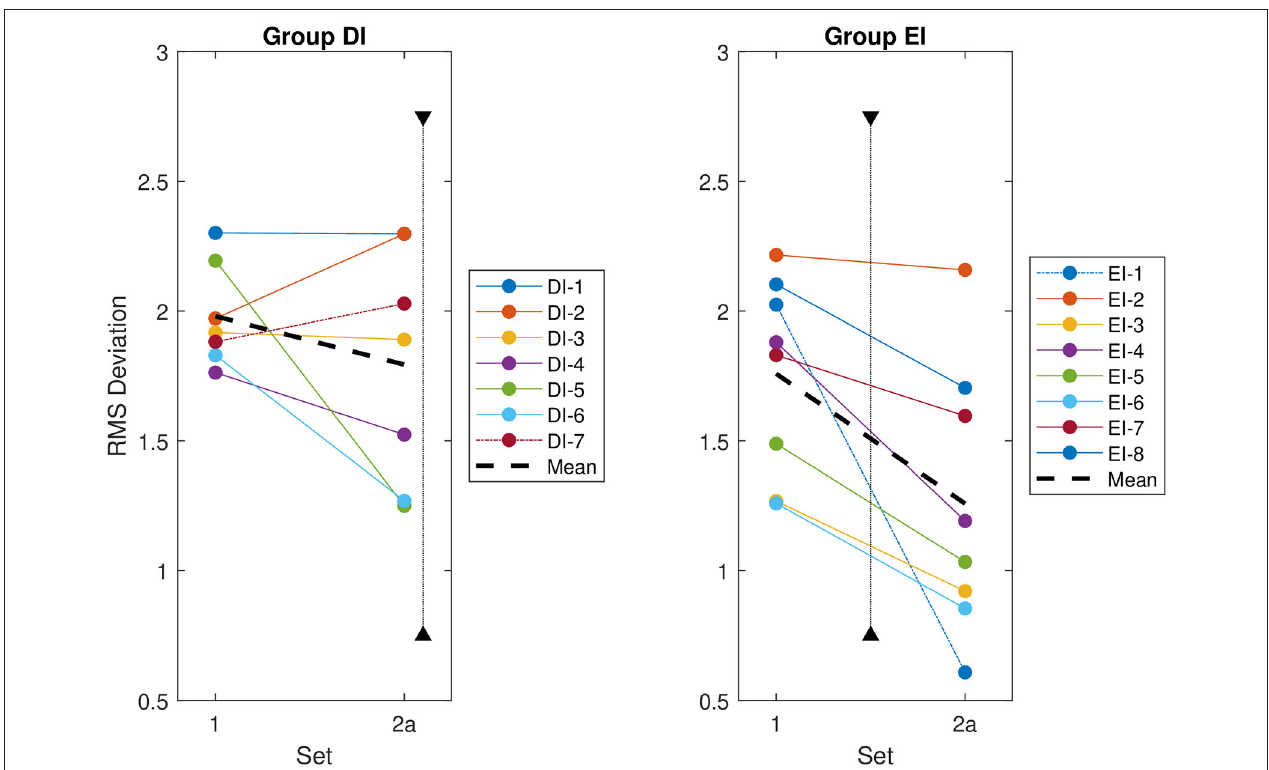
FIGURE 6 | Root mean square (RMS) deviation of each reviewer’s evaluations from the group mean for the first two datasets, regardless of whether an intervention has taken place. The RMS deviation for each reviewer is indicated by a solid line. The overall RMS deviation for each group is indicated by a thick dashed line. The special cases identified based on the intervention analysis—DI-7 for Group DI and EI-1 for Group EI—are indicated by dot-dashed lines. The timing of the intervention for each group is indicated by a vertical dotted line. This intervention occurs after Dataset 2a for Group DI, and between Datasets 1 and 2a for Group EI, as indicated on the